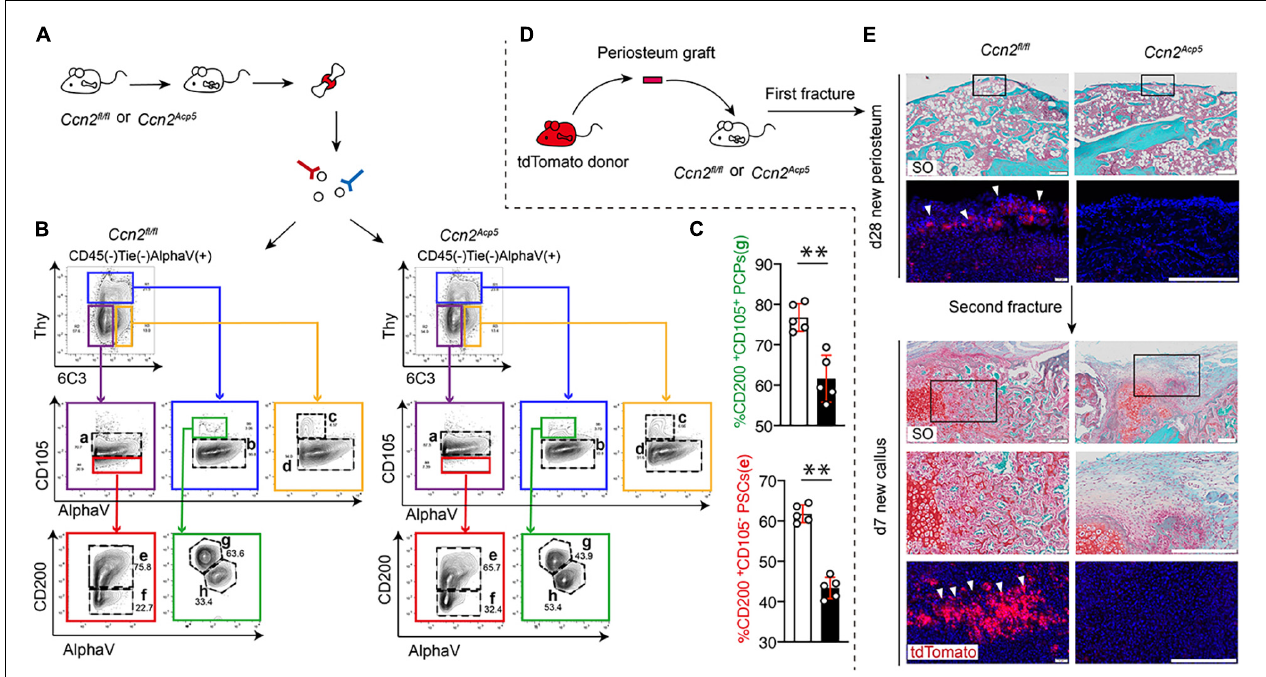
FIGURE 4 | CTGF from preosteoclasts is required to maintain the pool of PSCs and commit PSCs to chondrogenic lineage. After performing fractures on Ccn2 Acp 5 mice and Ccn2 fl / fl controls, the callus tissue was dissected and digested for Flow cytometry analysis (A) . Representative plots (B) and quantification (C) of [CD45 - Ter-119 - Tie2 - AlphaV + Thy - 6C3 - CD105 - CD200 + ] PSCs and [CD45 - Ter-119 - Tie2 - AlphaV + Thy - 6C3 - CD105 + CD200 + ] PCPs in the bone callus. (D) Schematic diagram of separating the periosteal graft from Tomato donor mice and transplanting it to the fracture site of Ccn2 Acp 5 mice and Ccn2 fl / fl controls. (E) Representative images of SO staining and DAPI/tdTomato immunofluorescence of fracture tibia after transplantation with tdTomato periosteal graft. In the new periosteum formed 28 days after the fracture, high magnification shows that the scarce periosteum-derived tdTomato + cells are integrated into the new periosteum (white arrow). After the second fracture, a large number of tdTomato + cells derived from periosteum were found in day 7 callus and formed cartilage tissue (white arrow). Scale bars, 200 µ m. Data are shown as mean ± SD. ∗∗ P <